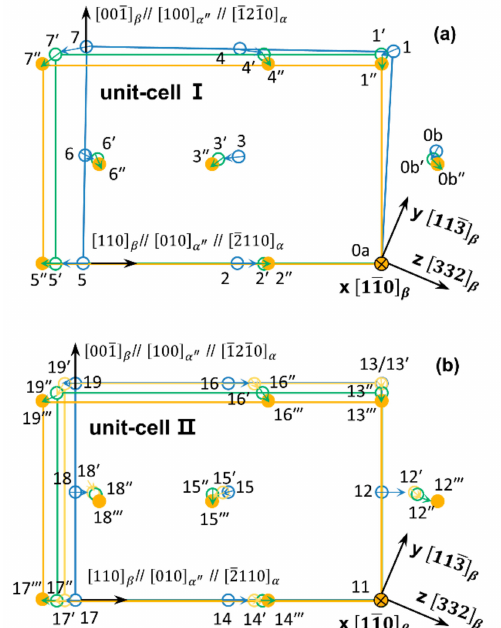
(cid:16) (cid:17) 110 plane at β